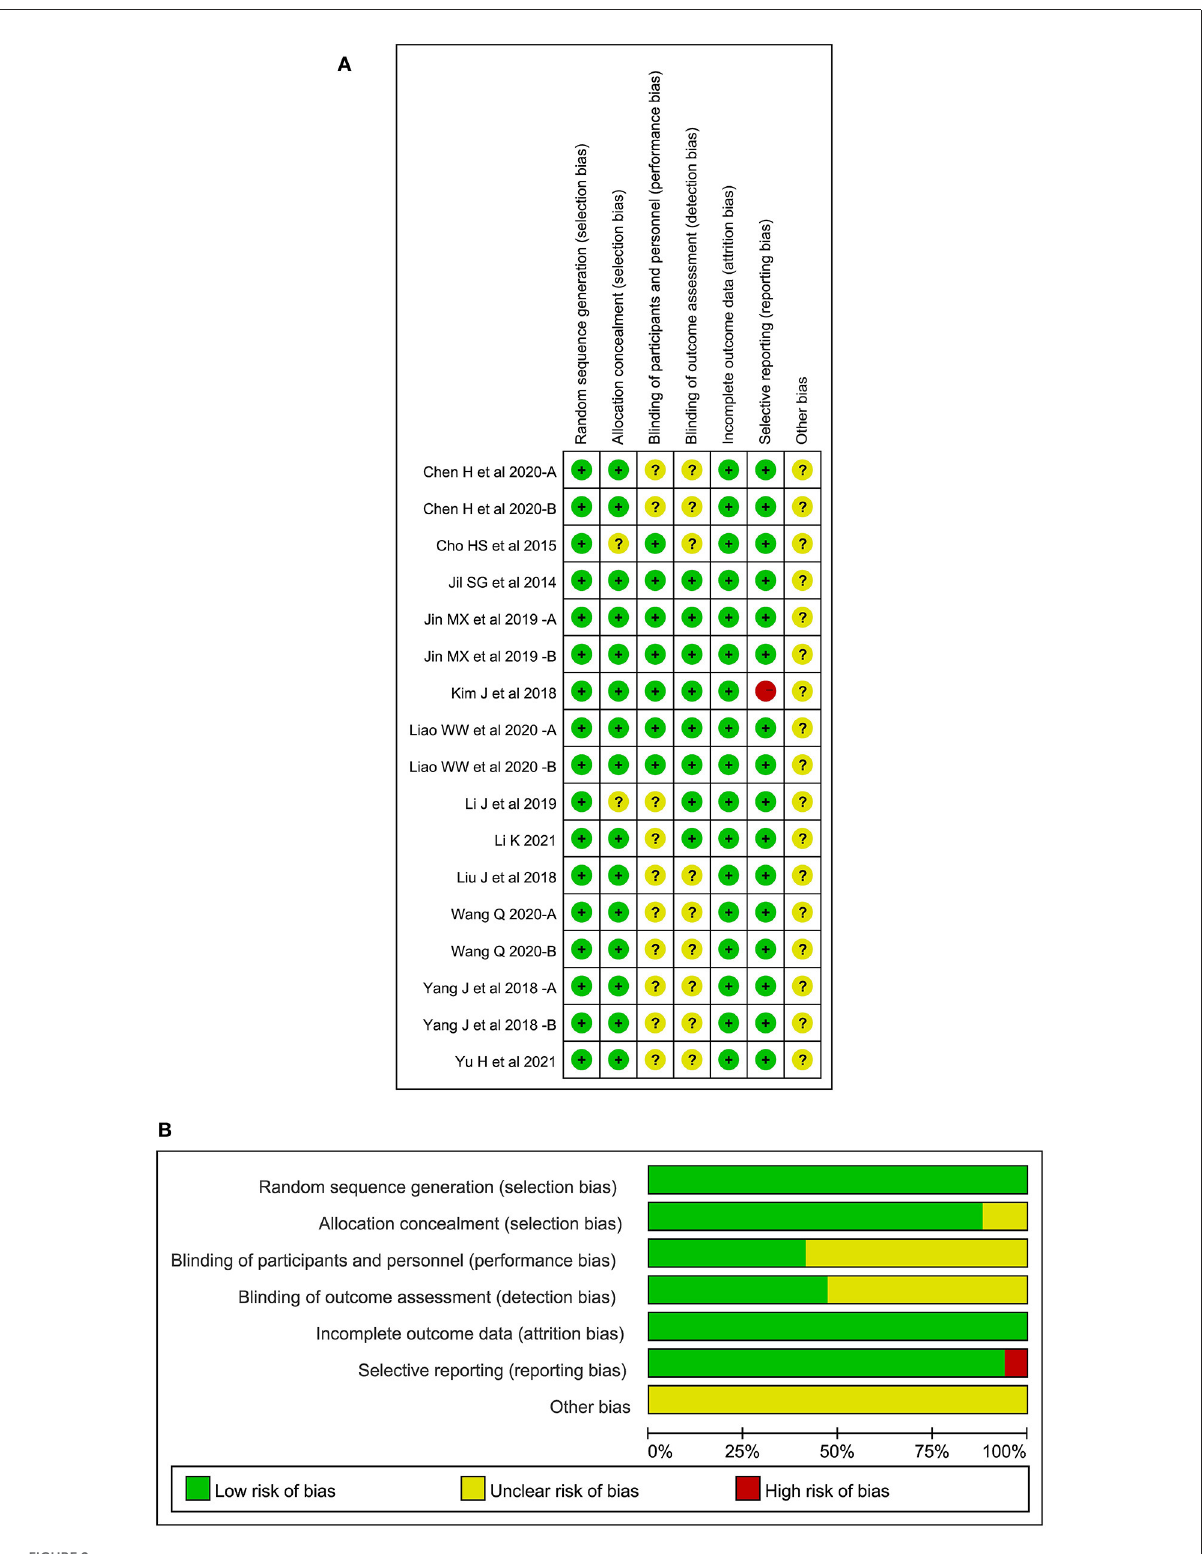
FIGURE2 (A) Risk of bias summary, (B) Risk of bias